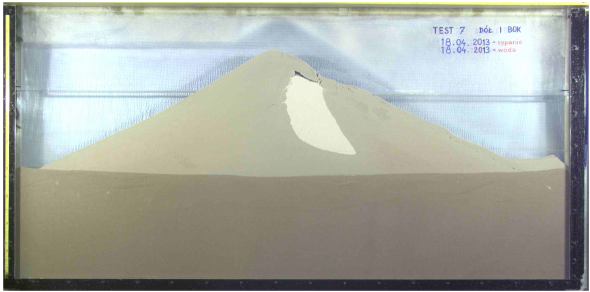
profile of the embankment, with the final one represented by the red line.